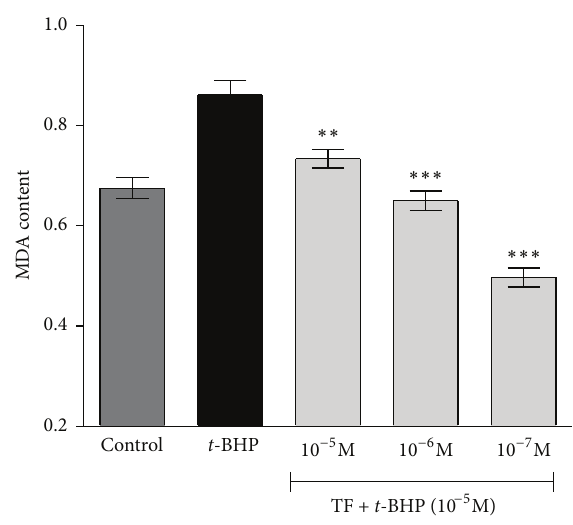
Figure 2: Concentration-dependent effect of black tea theaflavins on tert -butyl hydroperoxide- ( t -BHP-) induced changes in mal- ondialdehyde (MDA) content in normal Wistar rat erythrocytes. The effect of theaflavins was evaluated on erythrocytes subjected to oxidative stress by incubation with t -BHP (10 −5 mol/L). The MDA content is expressed as nmol/mL packed erythrocytes. ∗∗ 𝑃 < 0.05 ; ∗∗∗ 𝑃 < 0.001 as compared with t -BHP